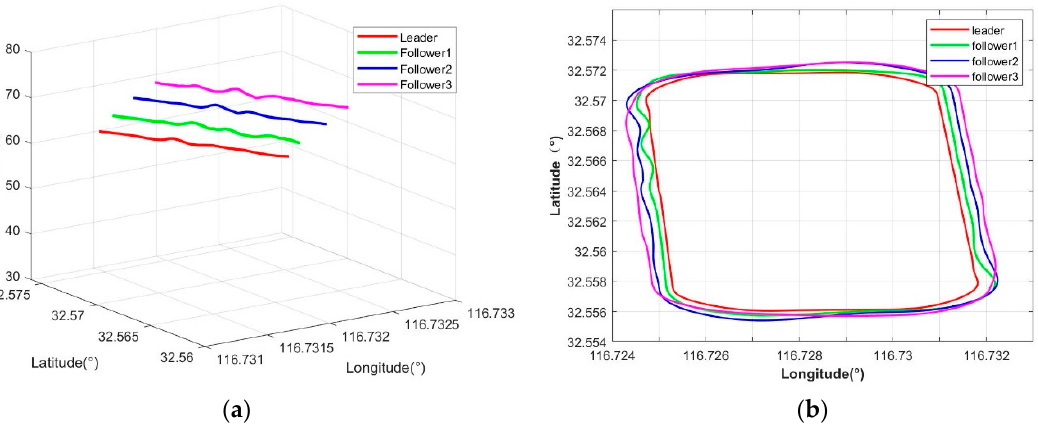
Figure 23. Actual flight route of the four-plane cooperative formation: ( a ) straight trajectory; ( b ) flight trajectory.